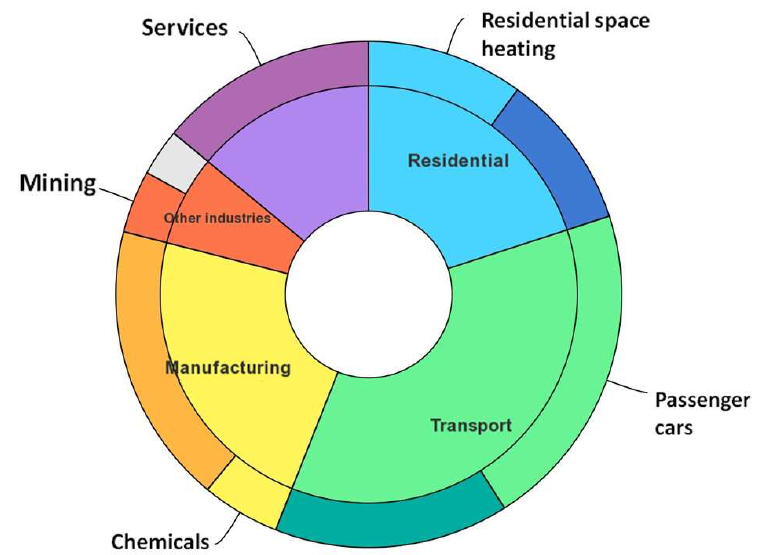
Figure 1. Largest end uses of energy by sector in selected IEA countries, 2018 [IEA (2021), Key World Energy Statistics 2021, IEA, Paris https://www.iea.org/reports/key-world-energy-statistics-2021], accessed on 15 September 2022.